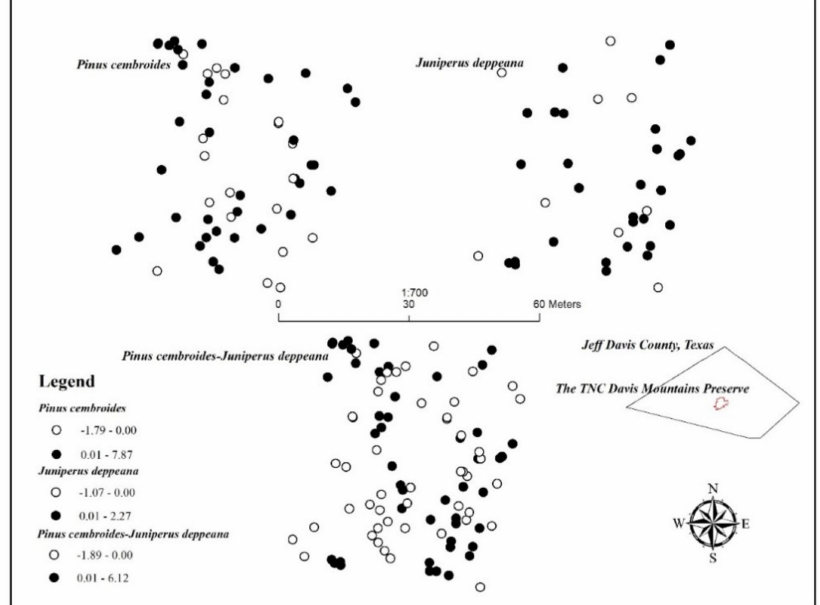
Figure 6. Anselin Local Moran’s I values for Mexican piñon ( Pinus cembroides var. cembroides Zucc.) (top left), alligator juniper ( Juniperus deppeana var. deppeana Steud.) (top right), and piñon–juniper (bottom middle) age data for 1965, 1985, and 2005 within study site 1. Trees of relatively similar age are presented by black circles, whereas trees of relatively dissimilar age are presented by open